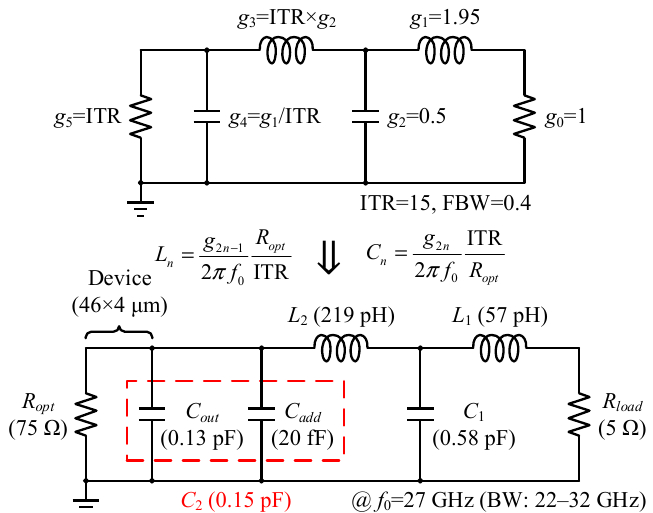
Figure 11. Conversion from a 0.1 dB equal-ripple low-pass filter prototype to a denormalized net- work.